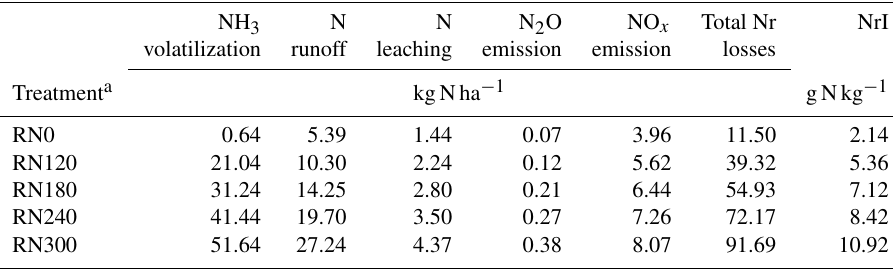
Table 5. The seasonal average reactive N (Nr) losses and reactive N intensity (NrI) for the two rice-growing seasons from 2013 to 2014 in the Taihu Lake region. NH 3 N N N 2 O NO x Total Nr NrI volatilization runoff leaching emission emission